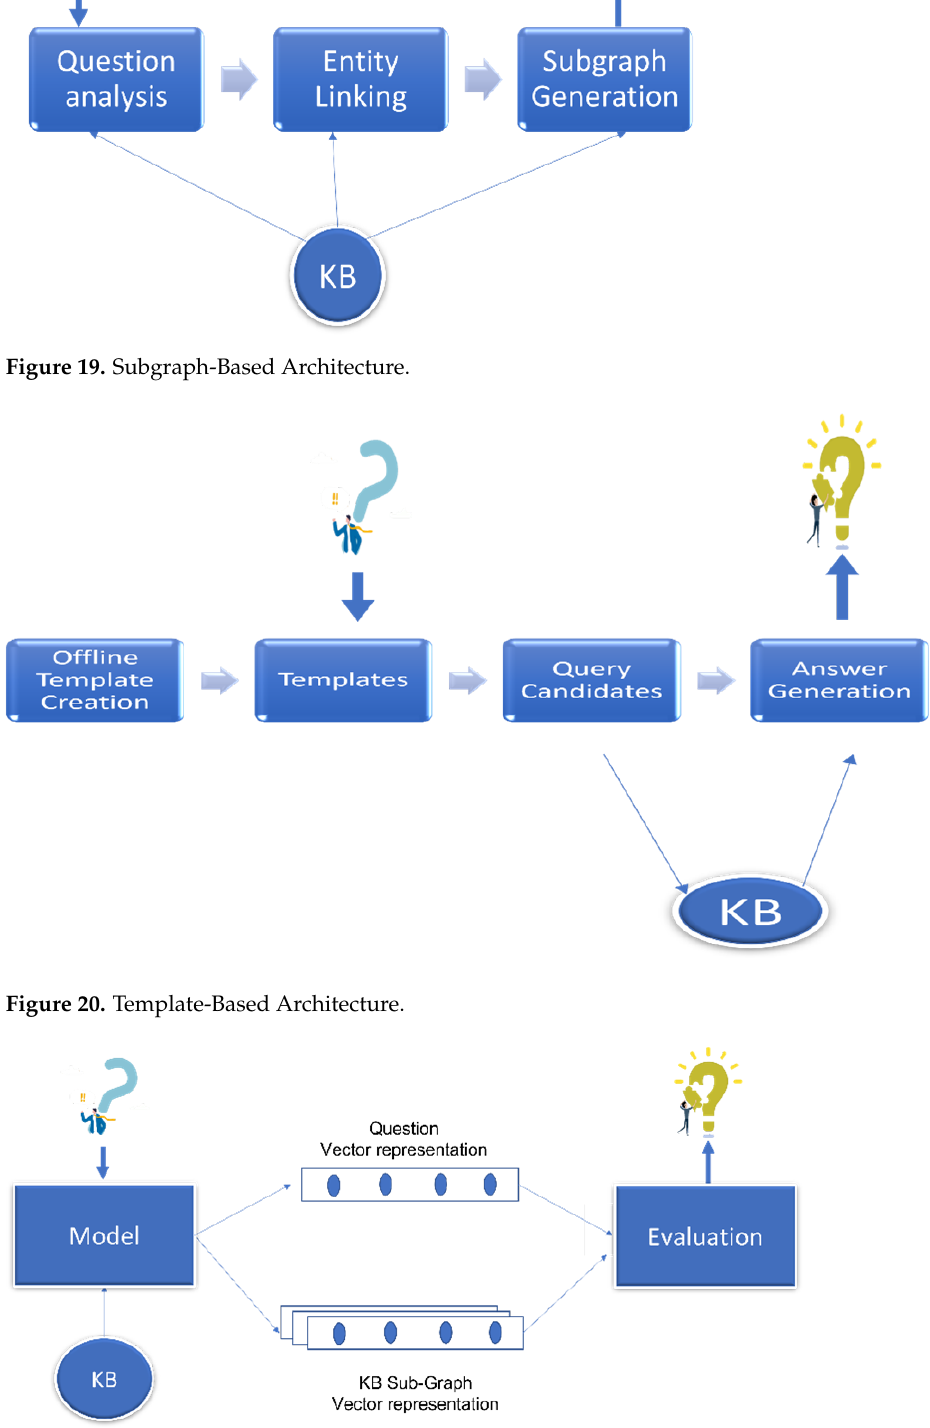
Figure 21. Information Extraction-Based